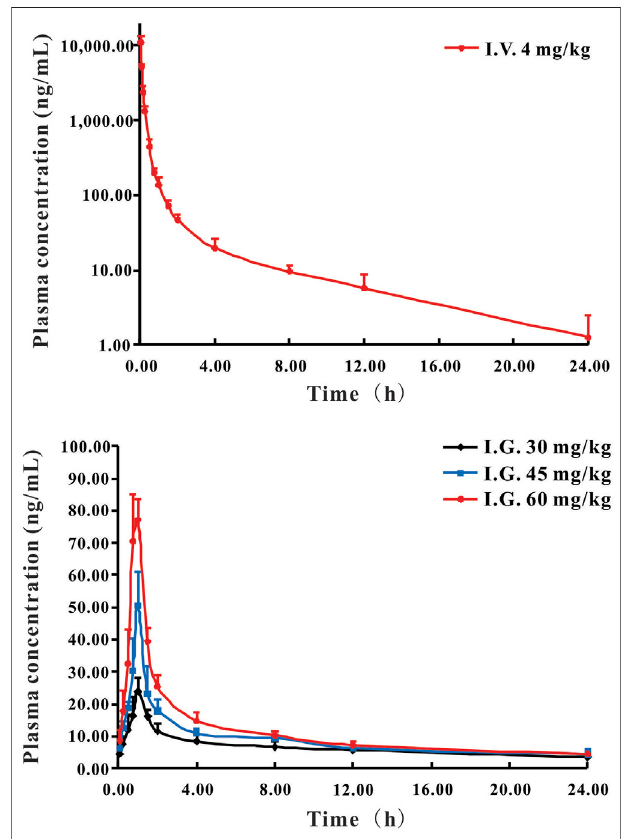
FIGURE 2 | Mean plasma concentration-time curves of DF in rats following i.v. administration (A) at 4 mg/kg and i.g. administration (B) at a single dose of 30, 45, and 60 mg/kg DF to rats (Mean ± SD, n (cid:1) 6).